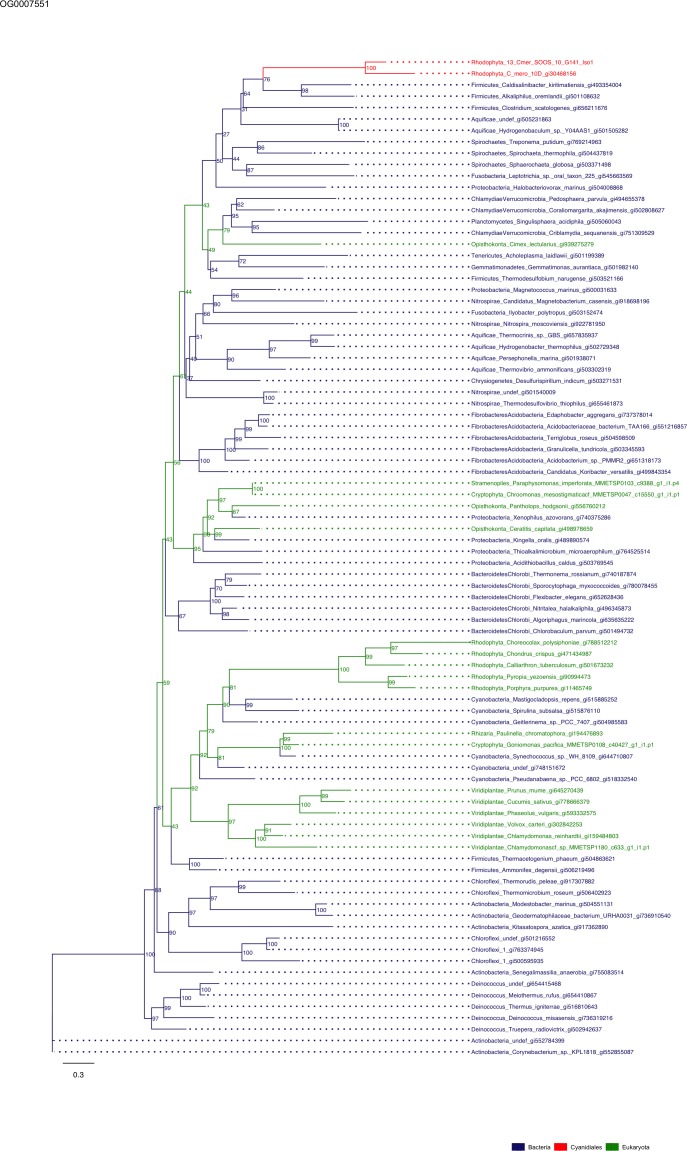
Sequence tree of orthogroup OG0007551.The tree is based on amino acid sequences. Archaea (yellow), Bacteria (blue), Cyanidiales (red), Eukaryotes including other red algae (green). Branches containing Cyanidiales sequences are highlited in red.